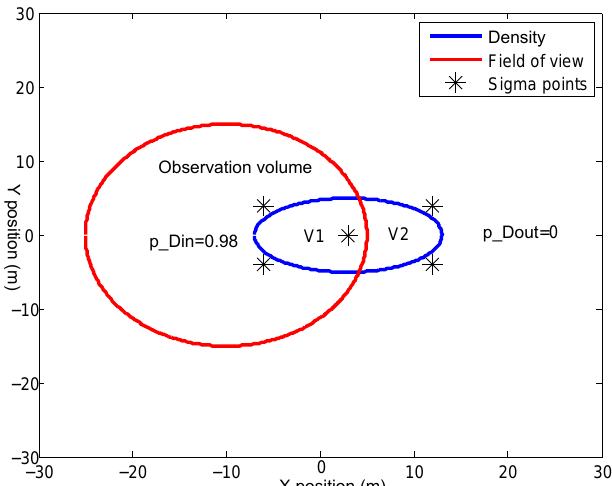
Figure 1. The predicted probability density function is shown by a Gaussian mixture (GM). The blue circle is one Gaussian item. V1 represents the part inside the observation volume, and V2 represents the outside